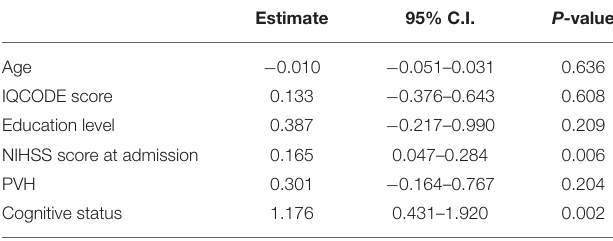
TABLE 3 | Ordinal regression analysis of mRS at 3